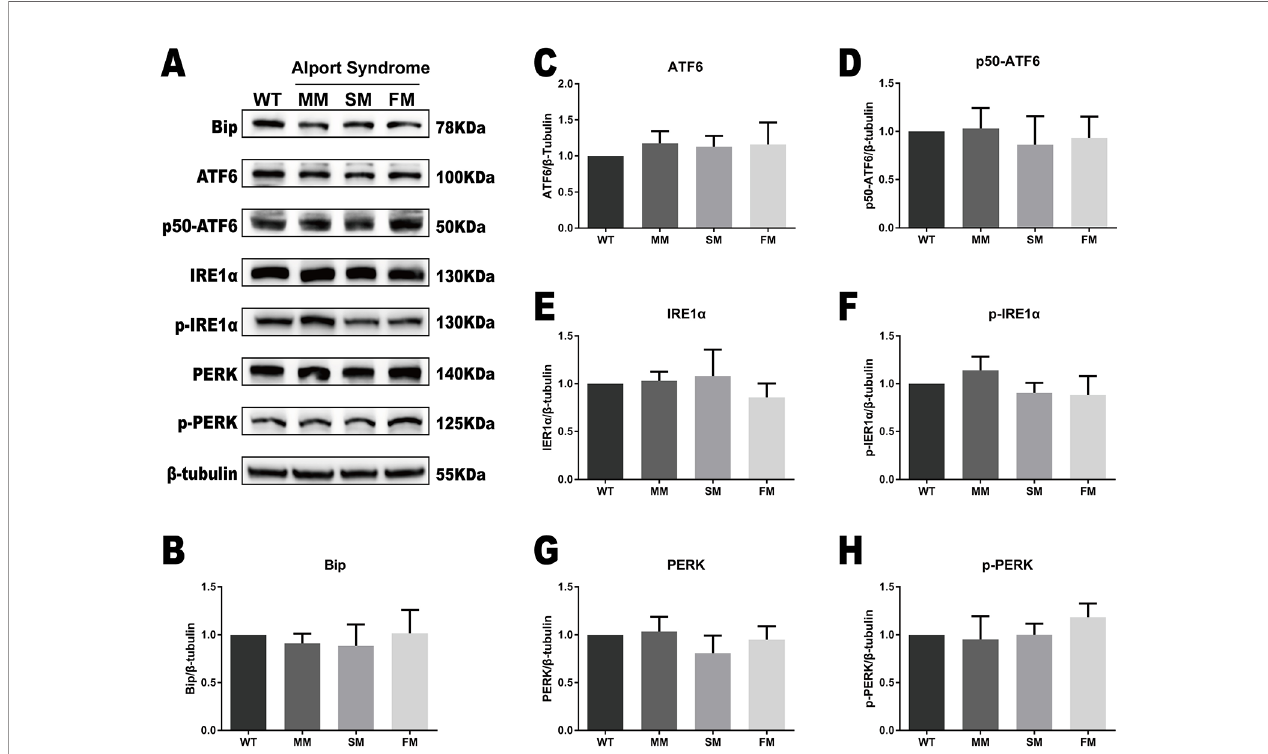
FIGURE 3 | The UPR protein levels are similar in WT and COL4A5 mutant iPSCs. (A) Protein expression of the UPR markers Bip, ATF6, p50-ATF6, p-IRE1 a , IRE1 a , p-PERK, and PERK was measured after reprogramming by western blotting. b -tubulin expression was used as an equal loading control. Representative blotting shows the protein levels of these proteins ( Supplementary Figure 1 ). (B – H) The expression of Bip, ATF6, p50-ATF6, p-IRE1 a , IRE1 a , p-PERK, and PERK in WT iPSCs, COL4A5 missense mutant iPSCs, COL4A5 splicing iPSCs and COL4A5 frameshifted mutant iPSCs were quanti fi ed by densitometric analysis. The protein levels of ER chaperone protein Bip, three ER transducers (ATF6, IRE1 a , and PERK) and their activated forms (p50-ATF6, p-IRE1 a , and p-PERK) were similar between the WT and mutant samples examined. Data are means ± SEM. n = 3, (WT, control; MM, missense mutation; SM, splicing mutation; FM, frameshift